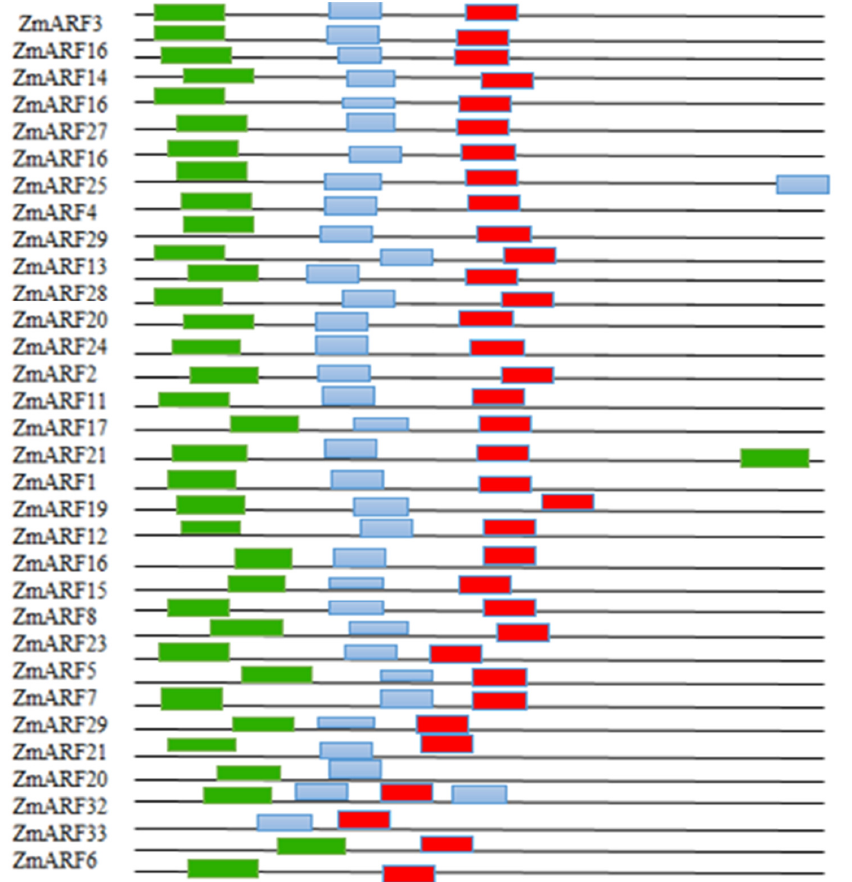
Figure 3. Conserved ZmARF protein motifs in maize, recognized by MEME database. Motifs 1-3 are identified by different